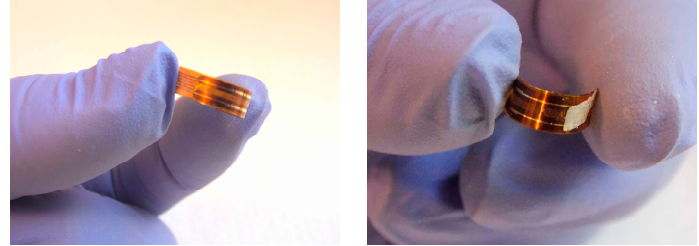
Figure 2. Optical image of the fabricated sensor.